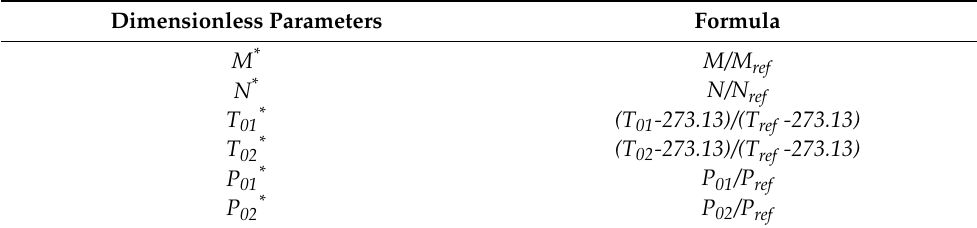
Table 7. Dimensionless experimental performance parameters of